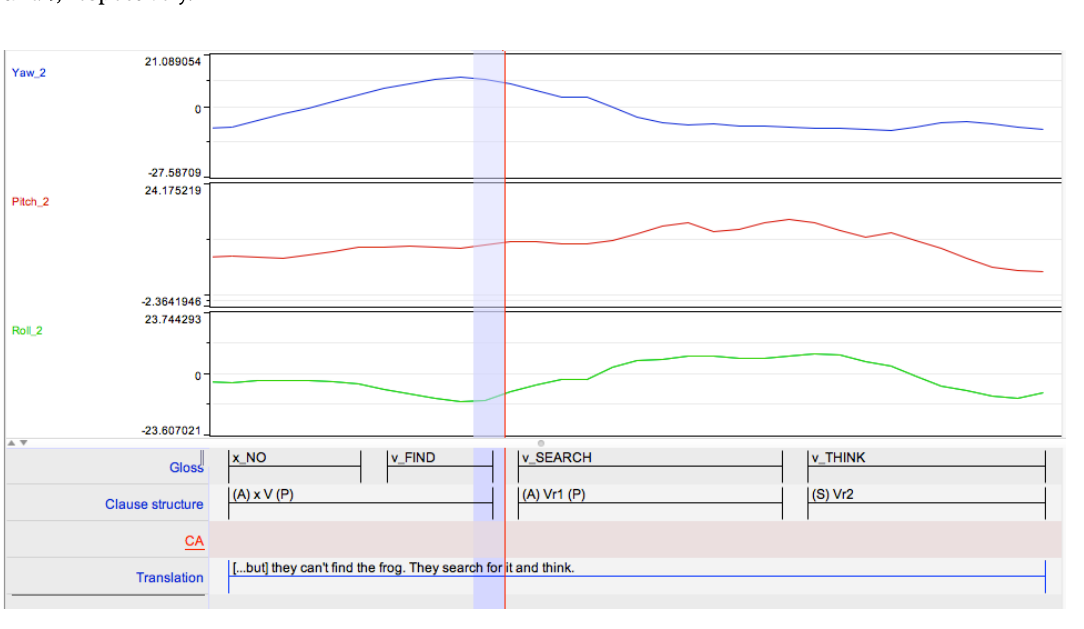
Figure 6. ELAN screenshot showing visualized head movement data for a two-sentence sequence. The example in Figure 6 represents a bit of narrative with no CA and includes three syntactically incomplete clauses, of which the second and third (after the crosshair that marks the sentence boundary) are coordinated conjunctively. From the perspective of manual structure, the behavior of the head movement contour in the dimension captured by the roll descriptor (the lowest panel) is more systematic than in the others. In practice, the roll value describes the sideways, tilting-like movements of the head. In Figure 6 we see that the syntactic juncture between the two sentences is associated with the lowest roll value, the descriptor thus forming a valley-shape over the juncture. In practice, with regard to the roll angle, the data tells us that the head position at the moment of the juncture is close to neutral whereas during the production of both sentences the head is tilted to the signer’s right (indicated by the increasing roll value in the positive direction). The two deviations in the roll dimension of the head position from the value of the juncture in the roll dimension are not random but align temporarily so that they last the exact duration of each of the two sentences and, thus, function to bind the two units together